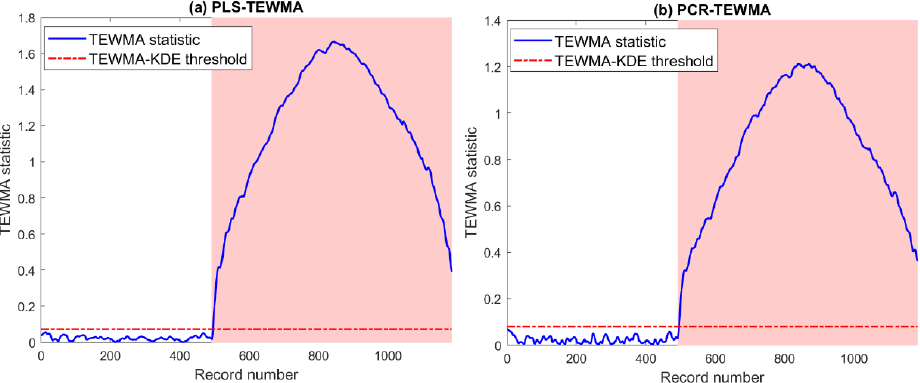
Figure 13. Detection results of ( a ) PLS and ( b ) PCR-based TEWMA charts in the presence of string